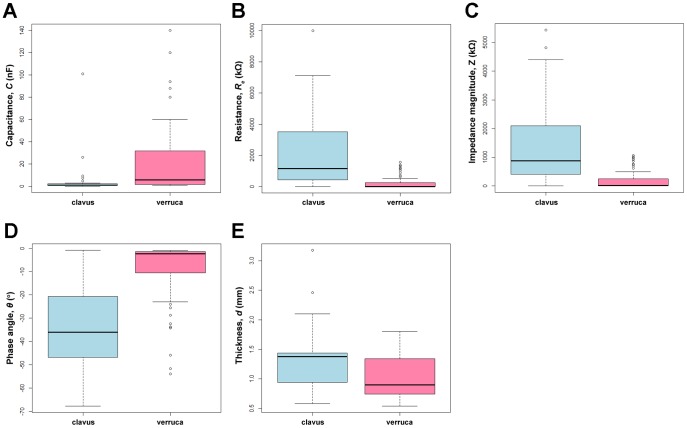
Conditional box plots of the all five measured indices, stratified by clavus and verruca.The lower edge, middle line, and upper edge of the box represent the 25th, 50th, and 75th percentiles of the distribution of the measured index, at 80 Hz. The box plots, A, B, C, D, and E, are for capacitance (C), resistance (Re), impedance magnitude (Z), phase angle (θ) and thickness (d), respectively.